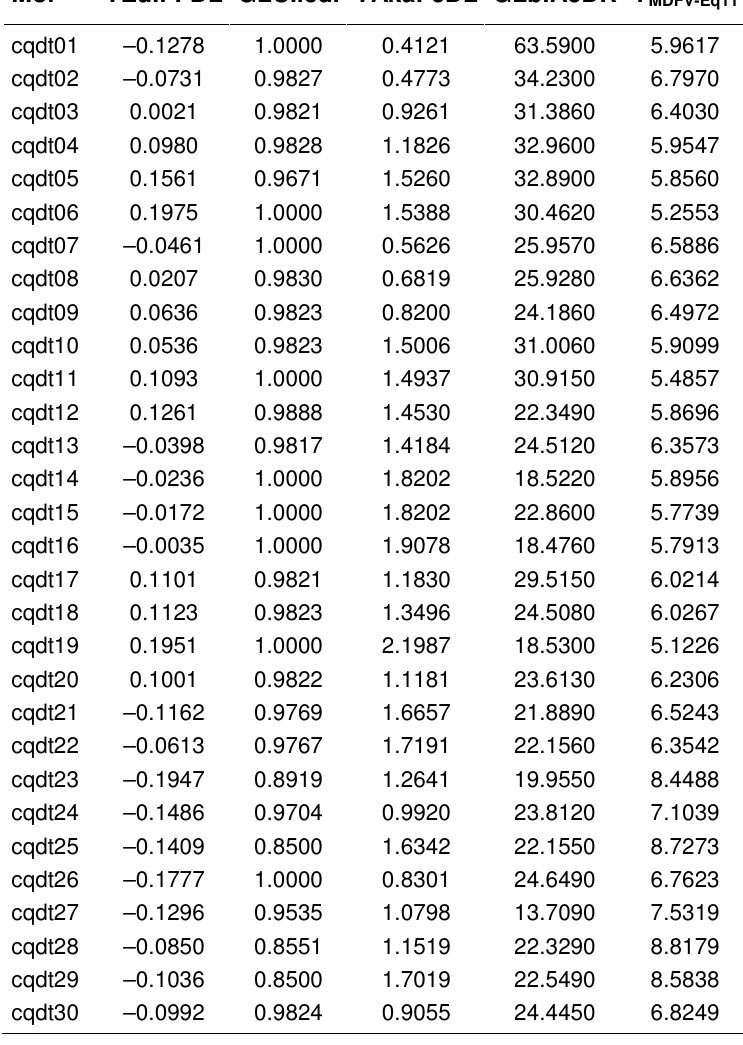
Inverse of Molar Concentration: Predicted Values on the External